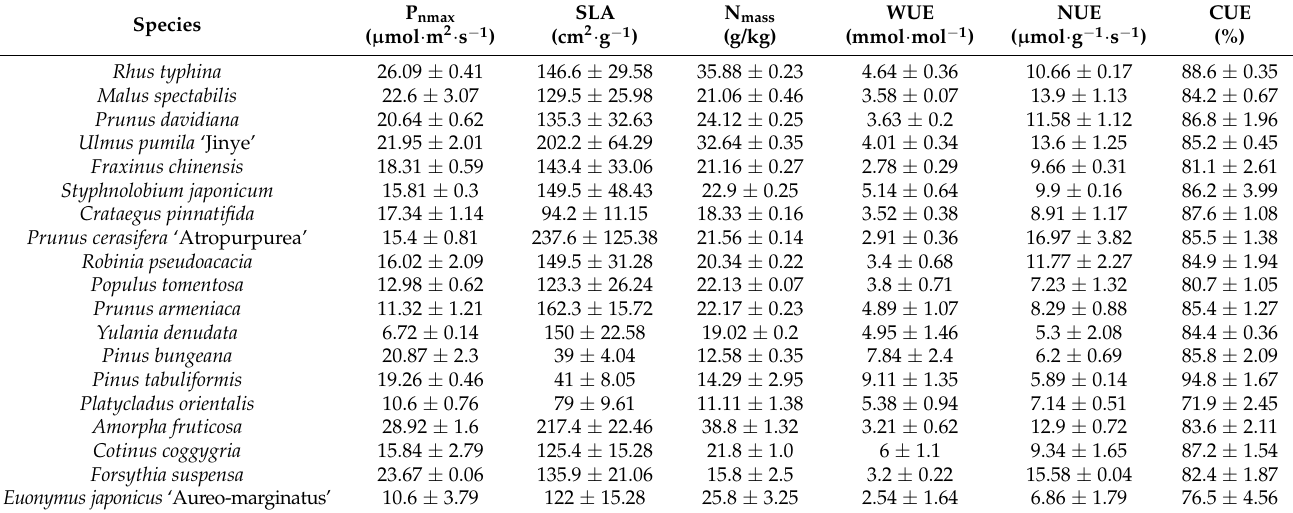
Table 2. The maximum net photosynthetic rate (P nmax ), specific leaf area (SLA), leaf nitrogen content (N mass ), water use efficiency (WUE), nitrogen use efficiency (NUE), and carbon use efficiency (CUE) of 19 species from the mixed plantation in Qinglonghu, Beijing (mean ±